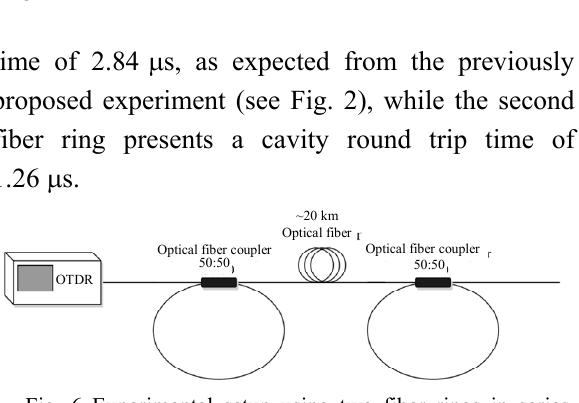
Fig. 6 Experimental setup using two fiber rings in series, directly interrogated by an OTDR.